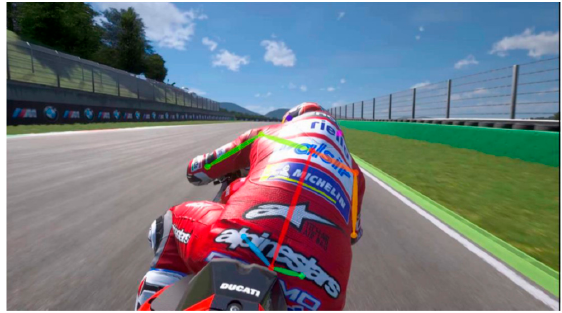
Figure 6. OpenPose postprocessing of MotoGP19 rear camera 2.